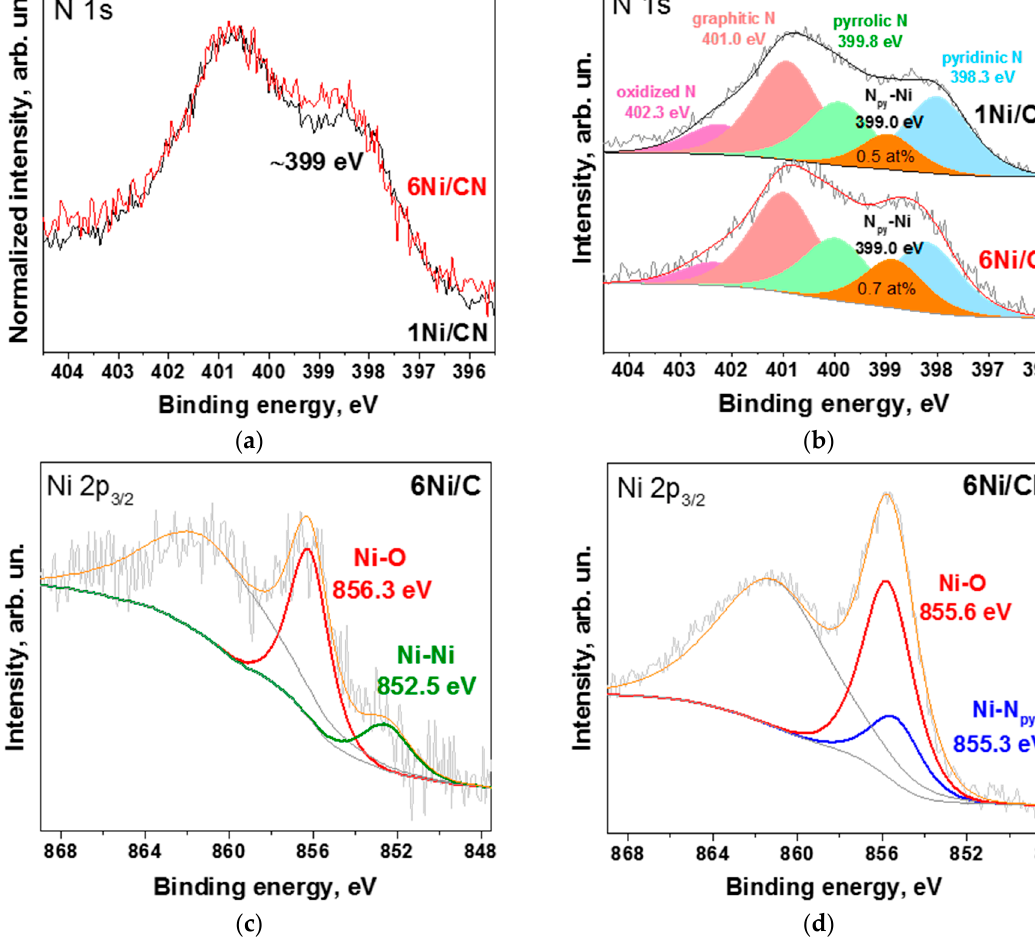
Figure 4. XPS N 1s spectra of 1Ni/CN and 6Ni/CN: ( a ) normalized and ( b ) fitted by five components; XPS Ni 2p 3/2 spectra of ( c ) 6Ni/C and ( d ) 6Ni/CN samples. All measurements were performed after the catalytic reaction.